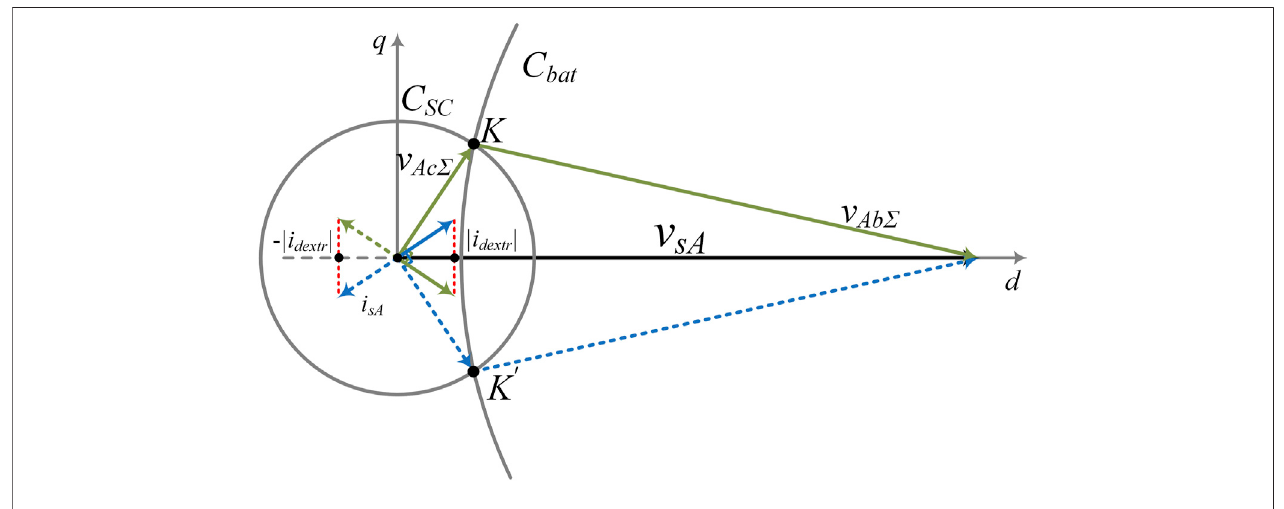
FIGURE 8 | Phasor diagram of extreme i d in SC voltage regulation